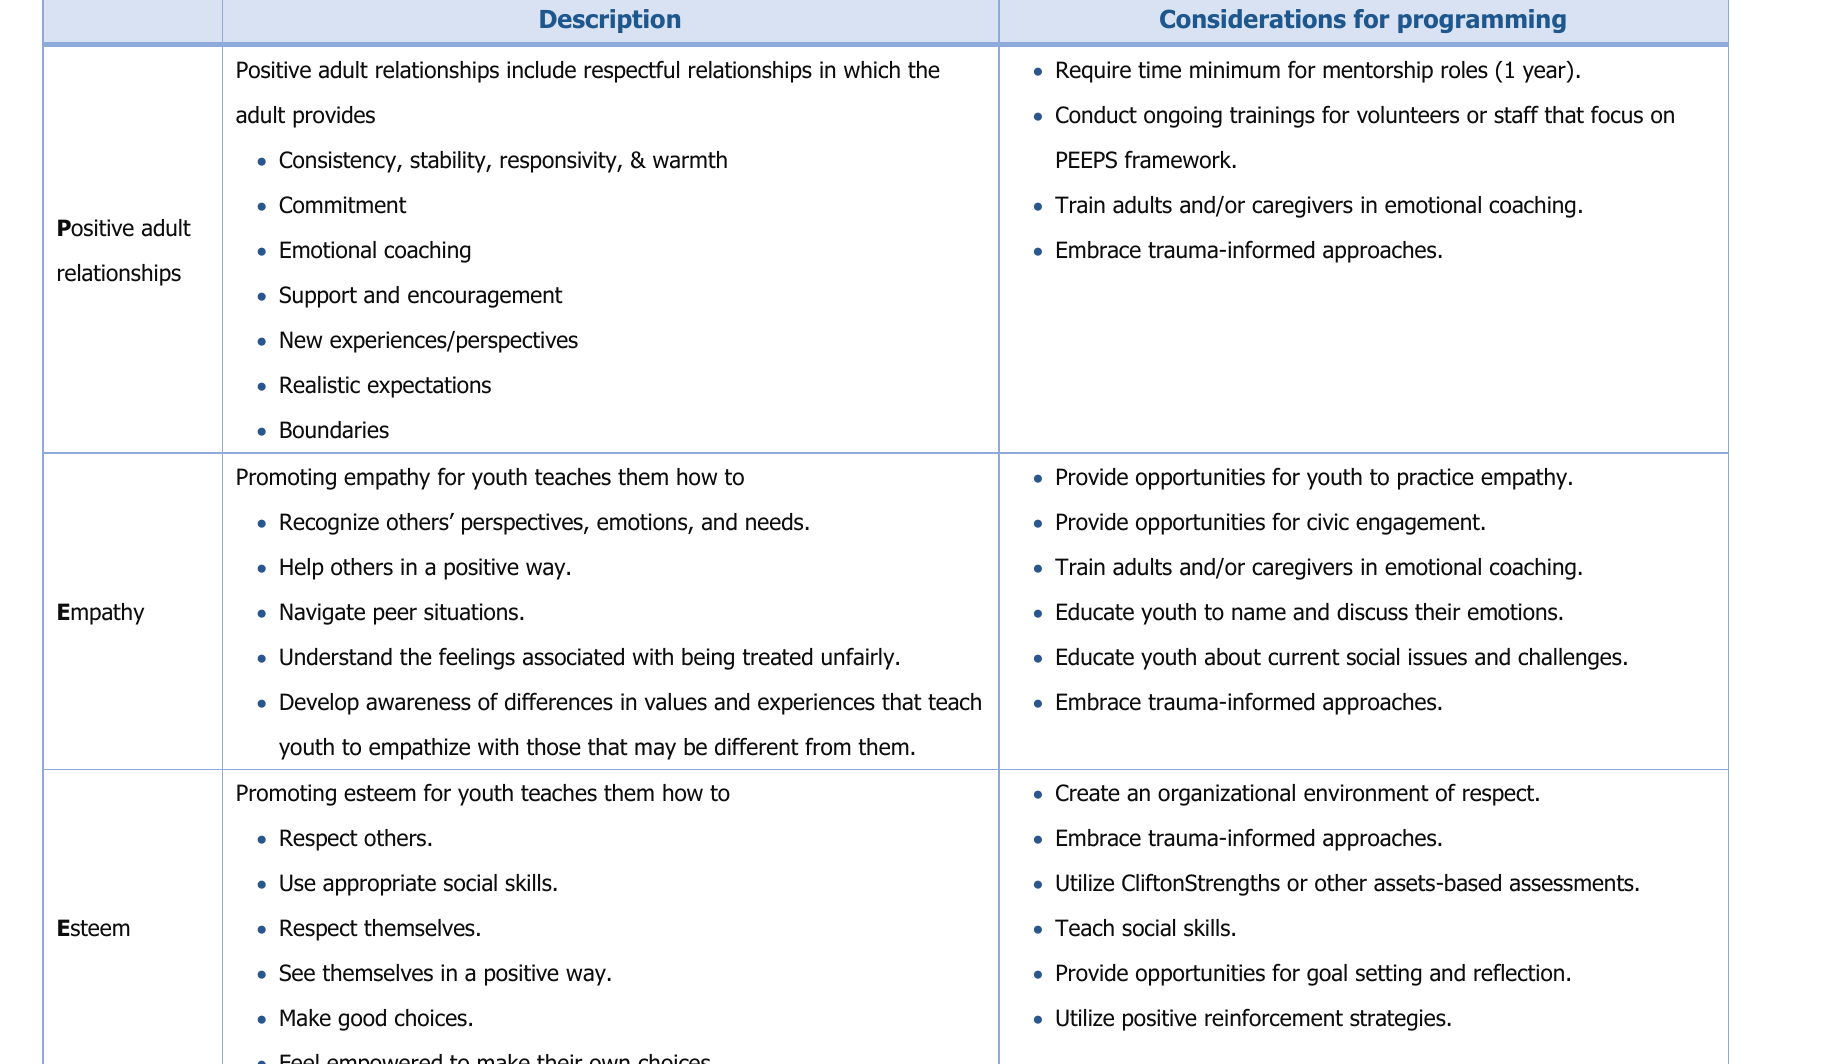
Table 1. PEEPS Framework for Promoting Relational